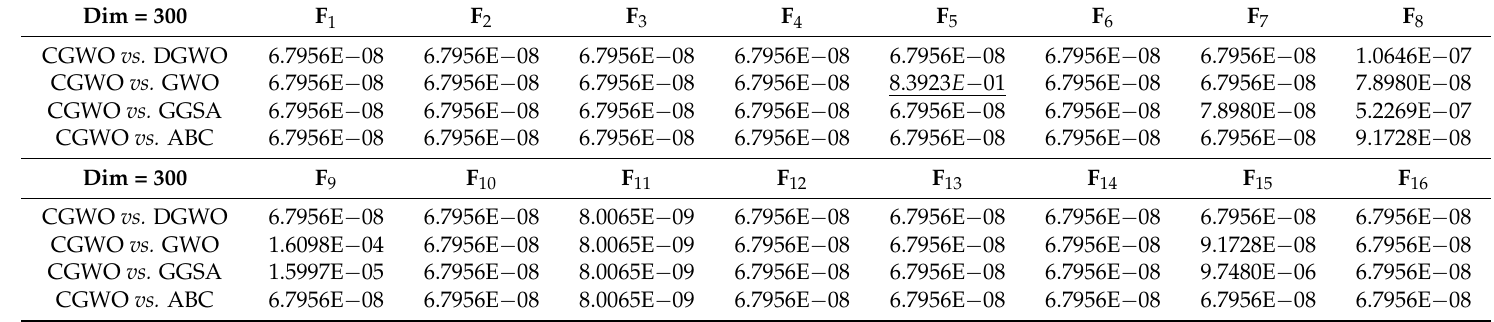
Table 11. p -values produced by Wilcoxon rank-sum test comparing CGWO vs. DGWO, GWO, GGSA, and ABC at Dim = 300 ( p ě 0.05 have been underlined). Dim =